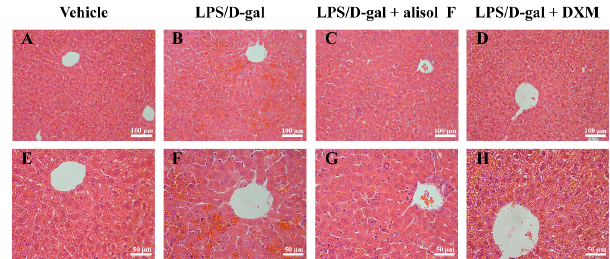
Figure 9. Alisol F improved histological alterations of LPS/ D -gal-induced liver injury. The liver samples stained with hematoxylin-eosin (H&E) stain and acquired the image under the magnification ( A – D ) original magnification 200× and E-H: original magnification 400×. ( A , E ) mice treated with vehicles; ( B , F ) exposed to LPS/ D -gal; ( C , G ) treated with Alisol F (20 mg/kg) and exposed to LPS/ D -gal; ( D , H ) treated with DXM (5 mg/kg) and exposed to LPS/ D -gal.